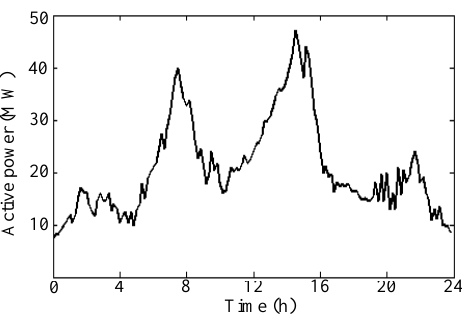
Figure 5. Daily active power curves at point of common coupling (PCC) of the wind farm.